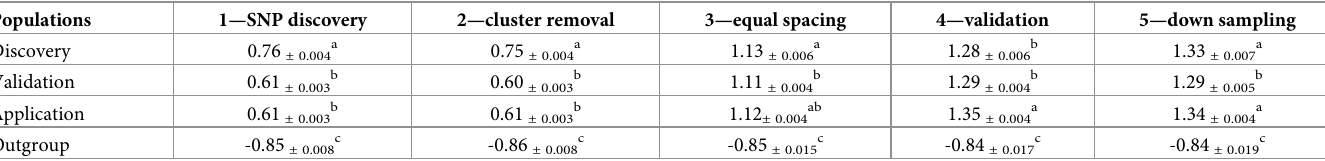
Table 2. OHE of the SNP sets out of the 50 random population